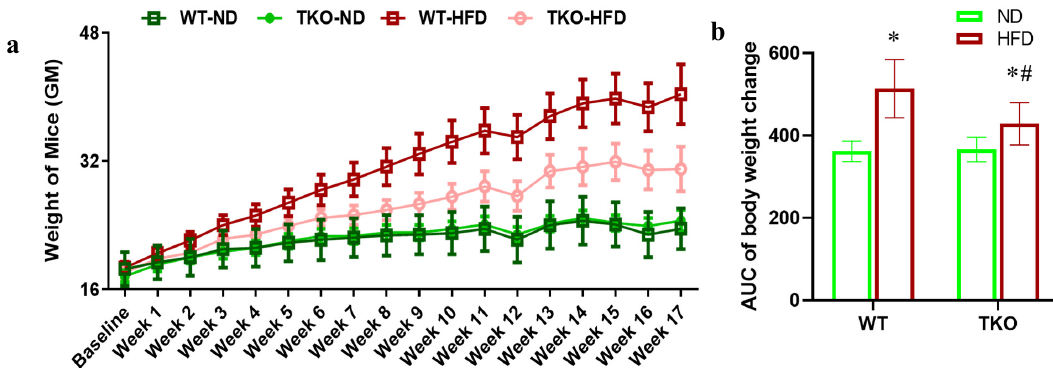
Table 1. Summary of the fasting blood glucose (FBG) levels of all animal groups. (Data are represented as mean ± SEM, n = 11–19 / group; * p -value < 0.05 vs WT-ND, and ¶ vs WT-HFD), ≠ vs TKO-ND.